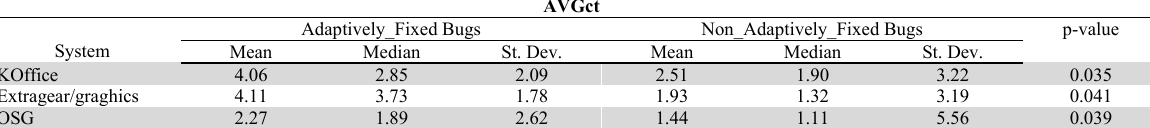
AVGCT measure (E.G., #MONTHS) inADAPTIVELY_FIXED and NON_ADAPTIVELY_FIXED BUGS: Decriptive statistics and Mann-Whitney test